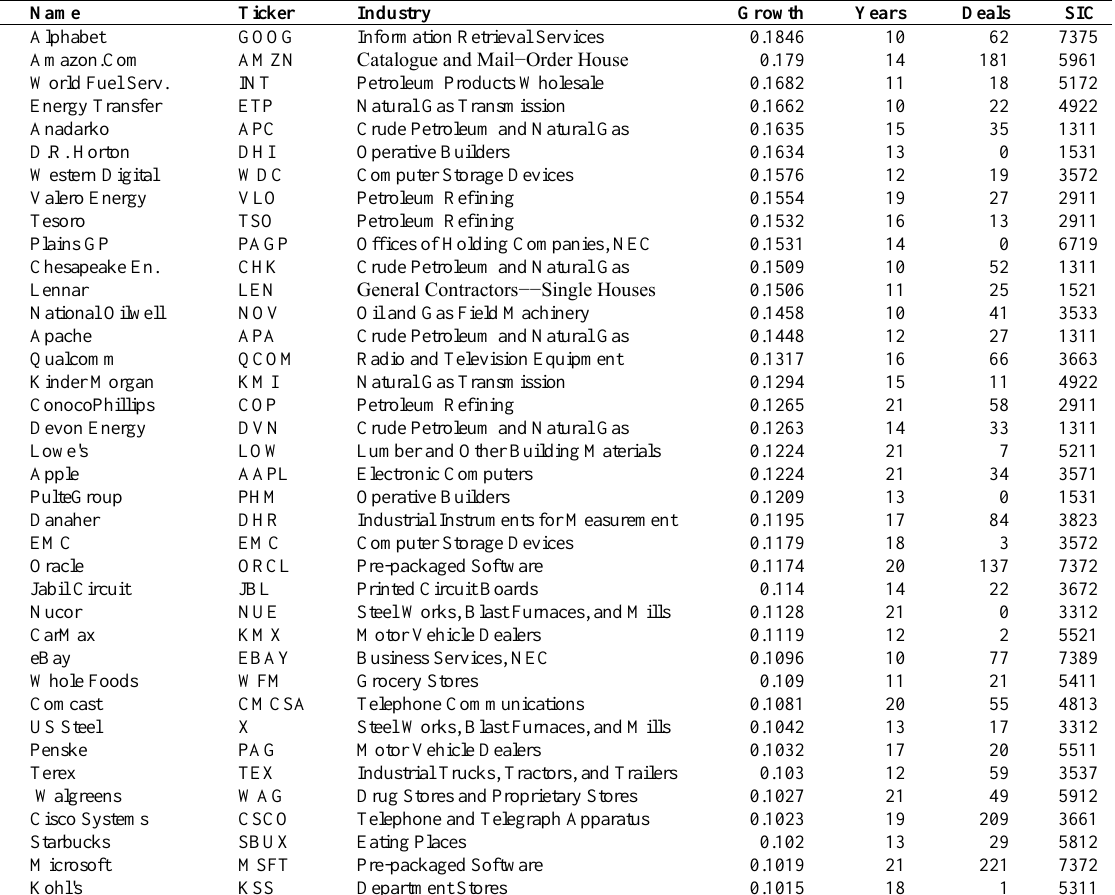
Table 1: Fastest Growing Firms (annual growth rate >